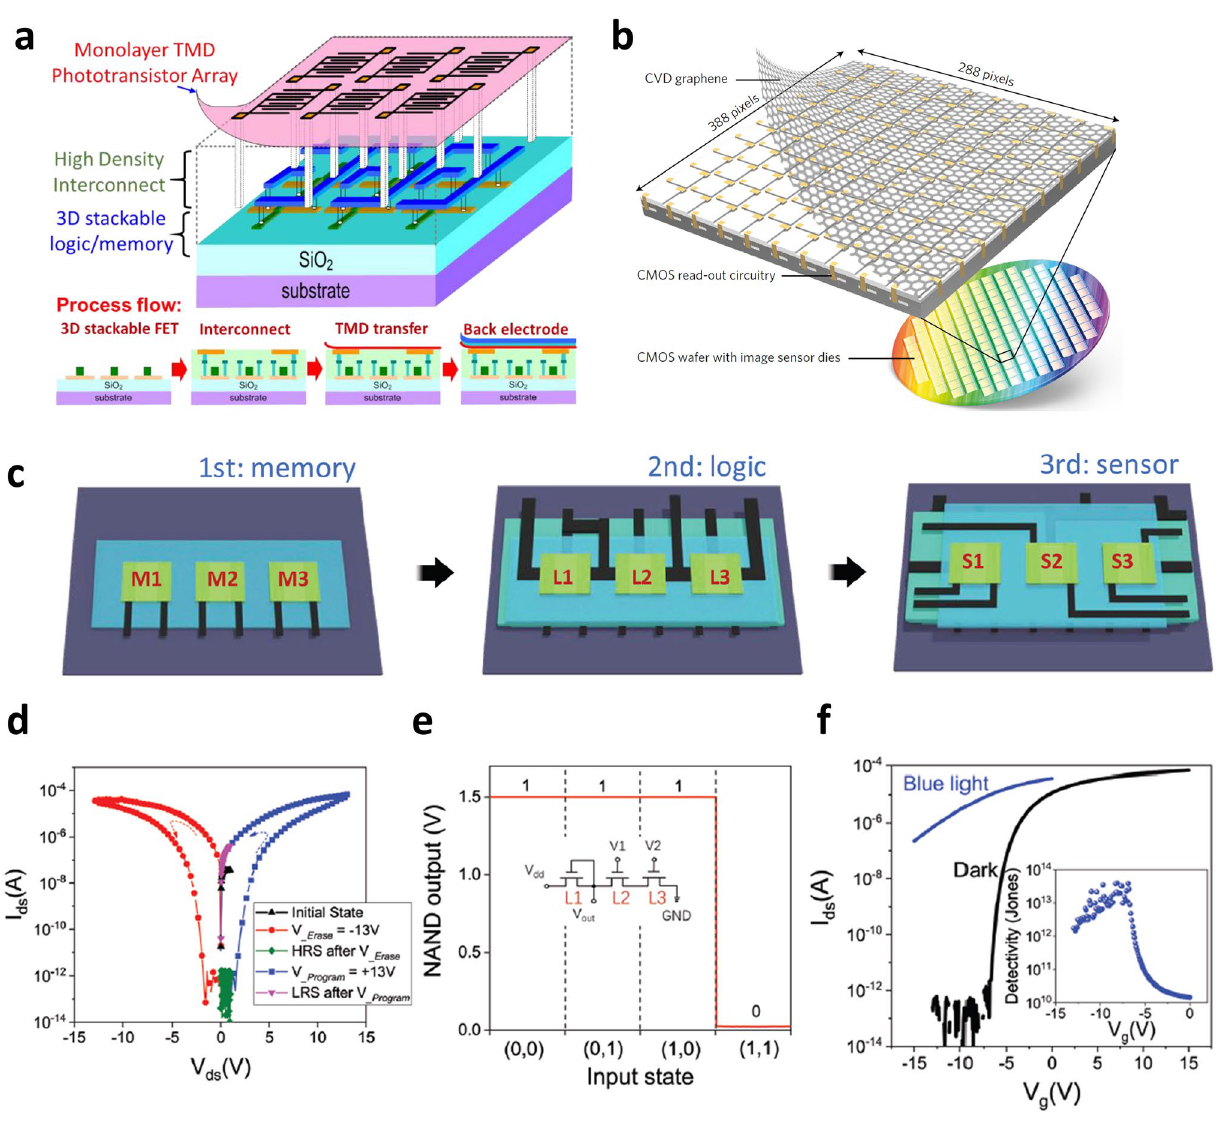
Fig. 9 a Schematic diagram of a monolithic 3D image sensor with a monolayer TMD phototransistor array integrated on Si nanowire FET- based logic/memory hybrid 3D integrated circuits [99]. Copyright © 2016, IEEE. b Back-end-of-line CMOS integration of CVD graphene with 388 × 288 pixel image sensor read-out circuit [16]. Copyright © 2017, John Wiley and Sons. c Schematic diagram in which various functions such as memory, logic, and optical sensor based on 2D materials are vertically stacked on different layers. d‑f Independent operation character- istics of memory (1st layer), logic (2nd layer), and optical sensor (3rd layer) located in each layer [13]. Copyright © 2020, John Wiley and